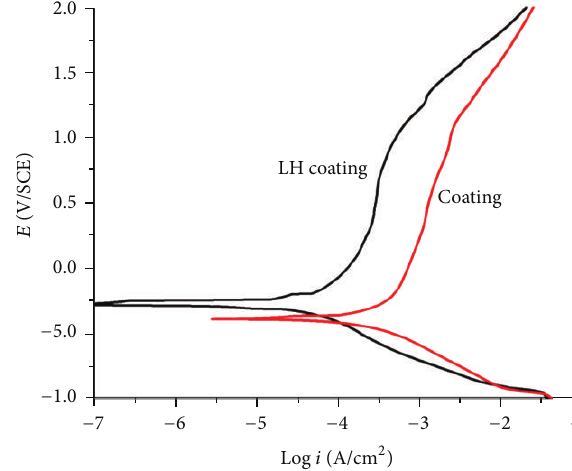
Figure 8: Potentiodynamic polarization of coating and LH coating in sea water (3.5%